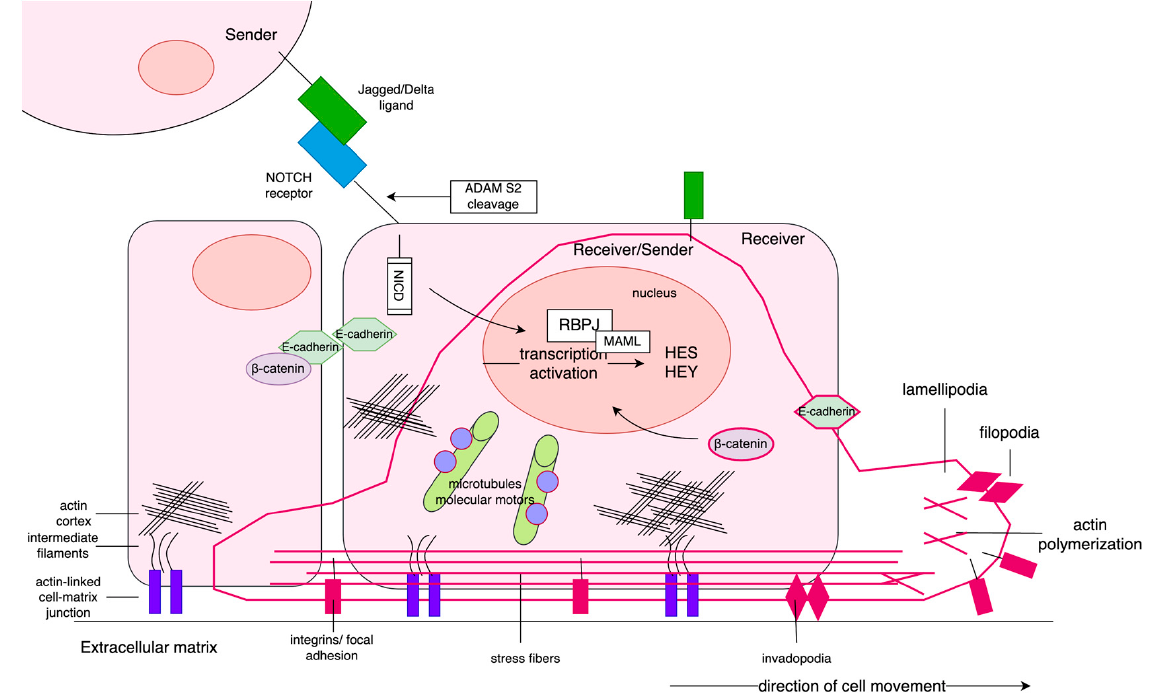
Figure 5. PC occurring in males below 55 years old showed intense activation of Notch signaling of Sender phenotype at early stage of disease, and, especially, at the late stage of disease through acquisition of hybrid Sender/Receiver phenotype (high expression of both Notch ligands and receptors). In turn, among males over 70 years old, Notch signaling has been diminished and turned into Receiver phenotype of PC cells at early stage of disease, whereas at the late-stage Notch has been inactivated. Downstream effects governed by Notch-specific TFs (HES/HEY) involved a change of cell morphology through reorganization of cellular architecture. The sedentary epithelial cells have apical/basal polarity, the cytoskeleton comprises the actin cortex, cytokeratin intermediate filaments, and microtubules with dynein and kinesin motors. The cell is anchored to the ECM by actin-linked laminin junctions, and the between-cells adhesion is asserted by E-cadherin bridges. Due to Notch signaling in younger males, PC cells undergo partial EMT triggered by ZEB2 concomitantly expressing epithelial ( CDH1 ) and mesenchymal ( CTNNB1 , FN1 ) markers. As demonstrated by the elements in dark pink, consequently, the cells start to migrate, pushed forward by contractions via stress fibers and detachment from the matrix eased by the activity of MMP7 . Finally, at the leading edge, the invading cells adhere by focal adhesion (involving LAMA1 ). Many of these features have been lost with disease progression, and tough gain in VIM has been noticed. The PC cells in older males demonstrated, in turn, inverse profiles to those of patients below 55 years old. Moreover, we observed a much-intensified activation of the EMT program through involvement of all specific TFs ( SNAI2 , TWIST1 , ZEB2 , HIF1A , SMAD3 ) at both stages of PC. Late-stage tumors restored the expression of CDH1, simultaneously maintaining CTNNB1 and VIM independent of PC stage. Tumors of both stages kept adhesive molecules like integrins and collagens. Importantly, high activity of microtubules and kinesin/dynein was kept.